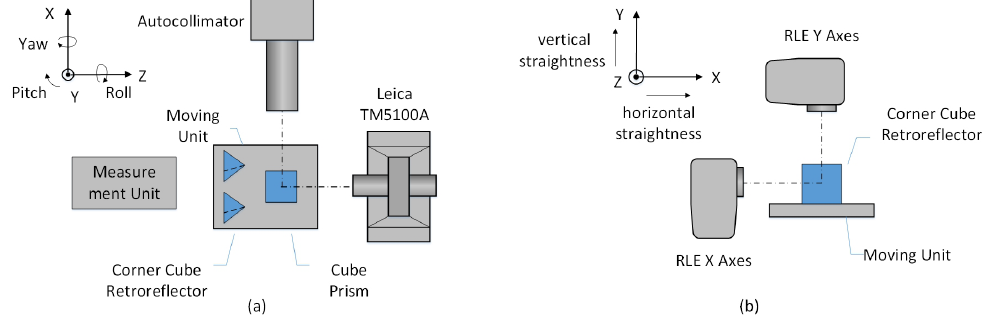
Figure 8. Calibrationexperiments. ( a )Setupfortheanglecalibration. ( b